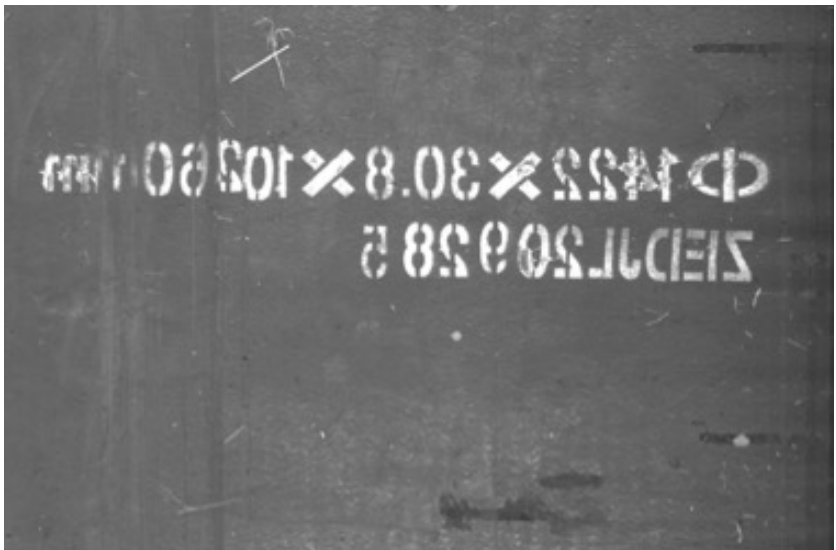
Figure 11. Information captured by inspection